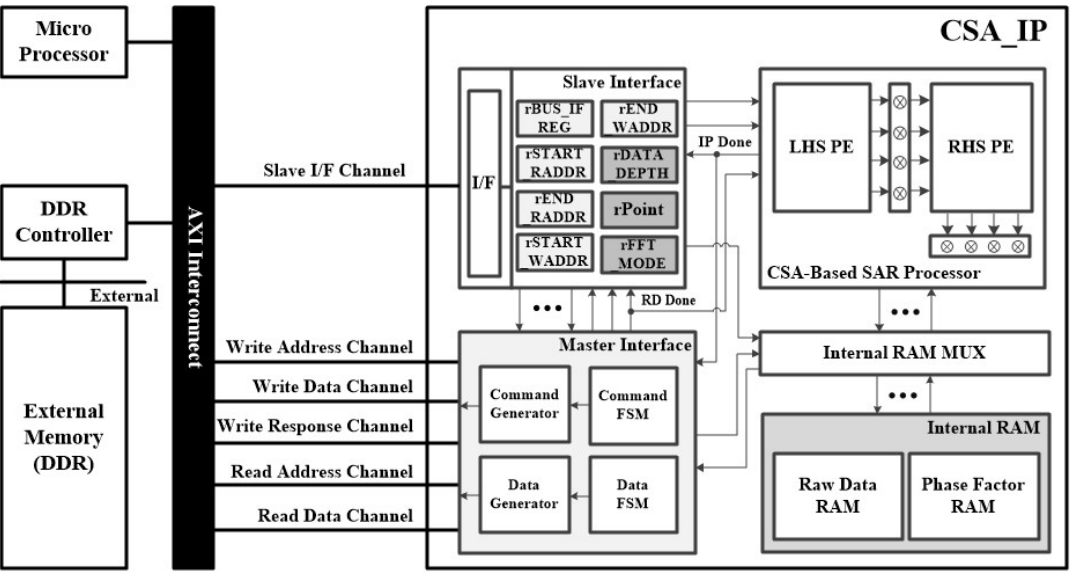
Figure 8. FPGA platform for the verification of the proposed CSA-based SAR processor.